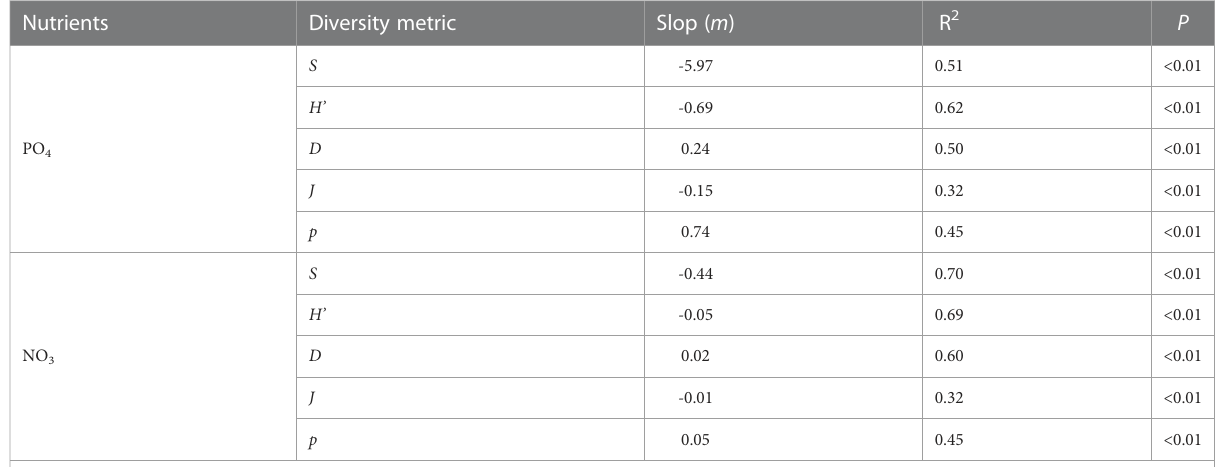
TABLE 1 The liner regressions between nutrient concentrations and diversity